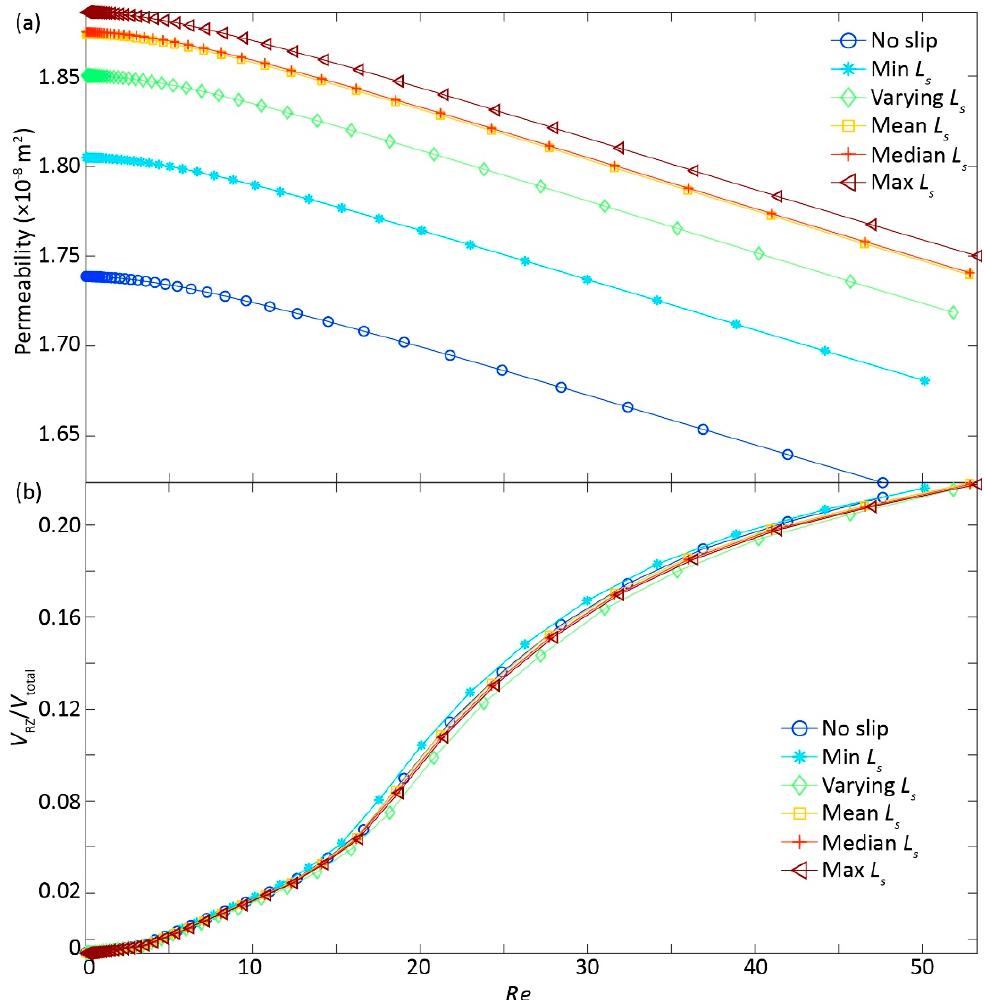
Figure 4. The relationships of permeability ( a ) and recirculation zone volume ratio ( V RZ / V total ) ( b ) with Reynolds number ( Re ) for six cases with a variety of slip lengths L s : case 1—no slip length with L s equal to 0; case 2—minimum L s assigned in the case 3; case 3—varying L s depending on aperture based on [20,21]; case 4—mean L s assigned in the case 3; case 5—median L s assigned in the case 3; and,